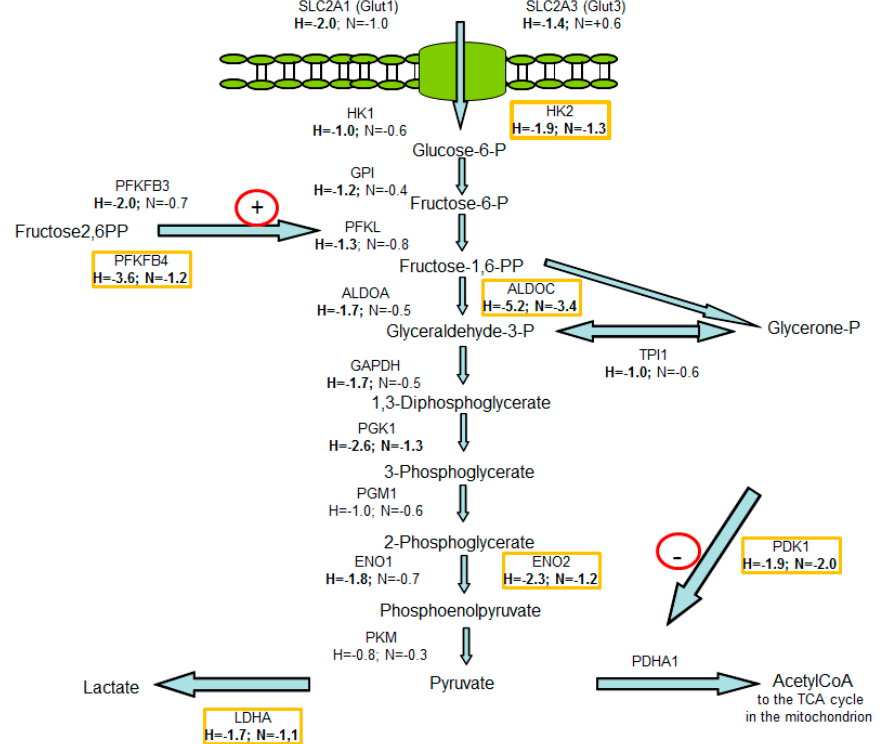
Figure 8. Gene mRNA levels using deep sequencing data of genes involved in glycolysis after HIF1 α was knocked down in the MDA-MB-231 cells. RNA was harvested 24 h after the start of the experiments. The experiments were performed in RPMI 1640 medium without glutamine but with 11.1 mM glucose. In this scheme, the mRNA levels are depicted as a ratio of untreated cells to HIF-siRNA transfected cells either under normoxic (N) or under hypoxic (H) conditions. Deep sequencing analysis was performed while using the hypoxic samples after the application of 5 mM L-glutamine and 1% fetal bovine serum (corresponding to lane 7* in Figure 1) and hypoxic samples that were additionally treated with HIF1 α -specific siRNA (corresponding to lane 8* in Figure 1) in four independent experiments. H (hypoxia)-describes the quotients of the transcript level of genes from the hypoxic HIF1-positive samples (corresponding to lane 7* in Figure 1) divided by the transcript level from the hypoxic HIF1-negative samples (corresponding to lane 8* in Figure 1). N (normoxia) describes quotients of the transcript level of the normoxic HIF1-positive samples (corresponding to lane 7 in Figure 1) divided by the transcript level of the normoxic HIF1-negative samples (corresponding to lane 8 in Figure 1). Genes marked yellow were significantly upregulated by HIF1 under normoxic conditions, as was validated using qPCR (Supplemental Figure S16, Supplemental Tables S1 and S2). Figure was adapted from